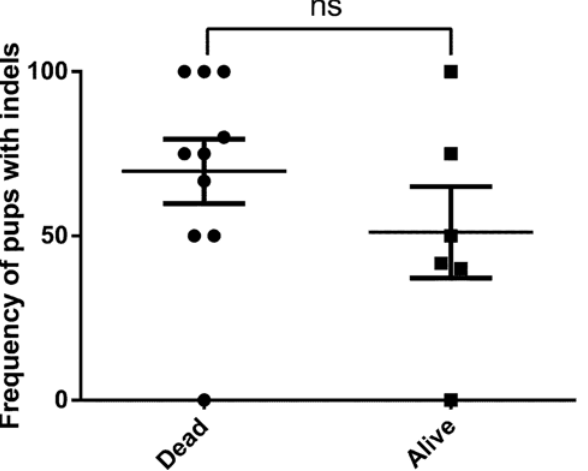
Figure 10. Indel frequency in Cas9-modified mice does not correlate with survival. The number of pups with indels, regardless of survival, is plotted as a frequency per injection. All mice that did not survive to at least 3 weeks were categorized as “ dead ” . A total of 16 independent injections (dead = 10, alive = 6) with range, mean, and SEM are plotted. p = 0.28, Two-tailed Student ’ s t -test. ns: